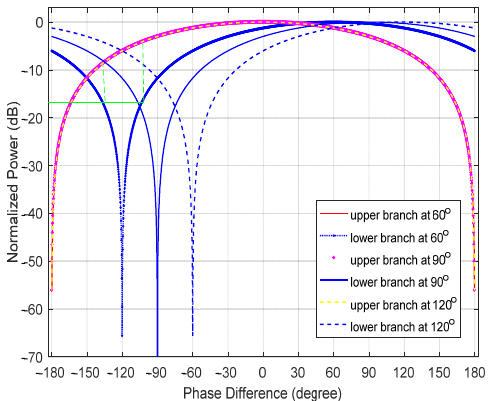
Figure 2. The normalized power of the output signals versus phase difference of the two echo signals at different phase difference between the two reference signals.